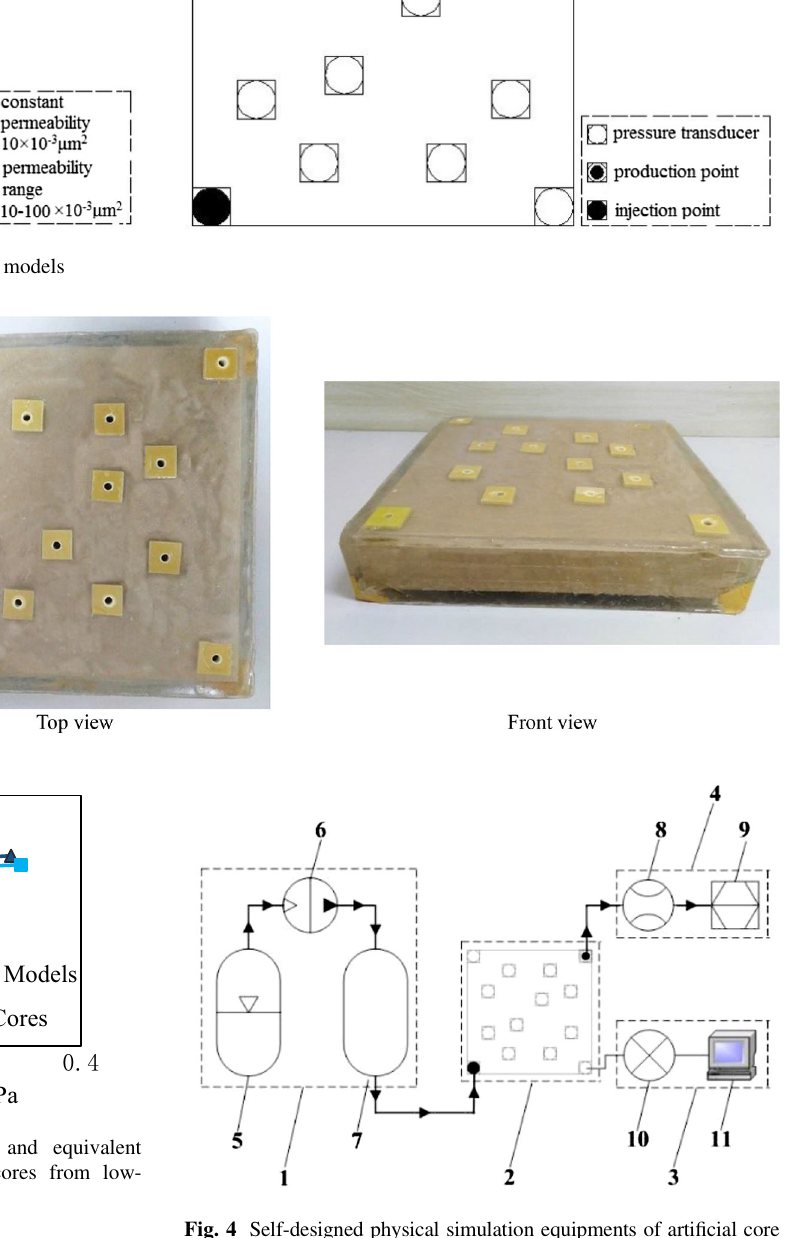
Fig. 4 Self-designed physical simulation equipments of artificial core plate models. 1 Injection and controlling system; 2 Artificial core plate modelauxiliarysystem;3Pressuremeasurementandrecordingsystem;4 Production and measurement system; 5 High-pressure pump; 6 Pressure stabilizingdevice;7Injectionfluidtank;8Micro-flowmeter;9Electronic balance; 10 Pressure inspection instrument; 11 Recording